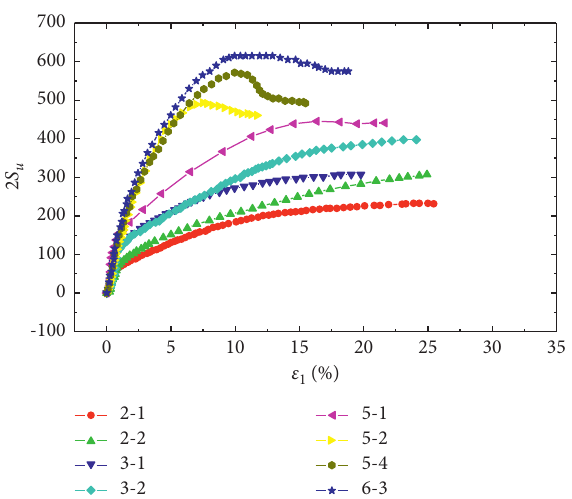
Figure 7: Stress-strain curves of the consolidated undrained triaxial test for each layer of